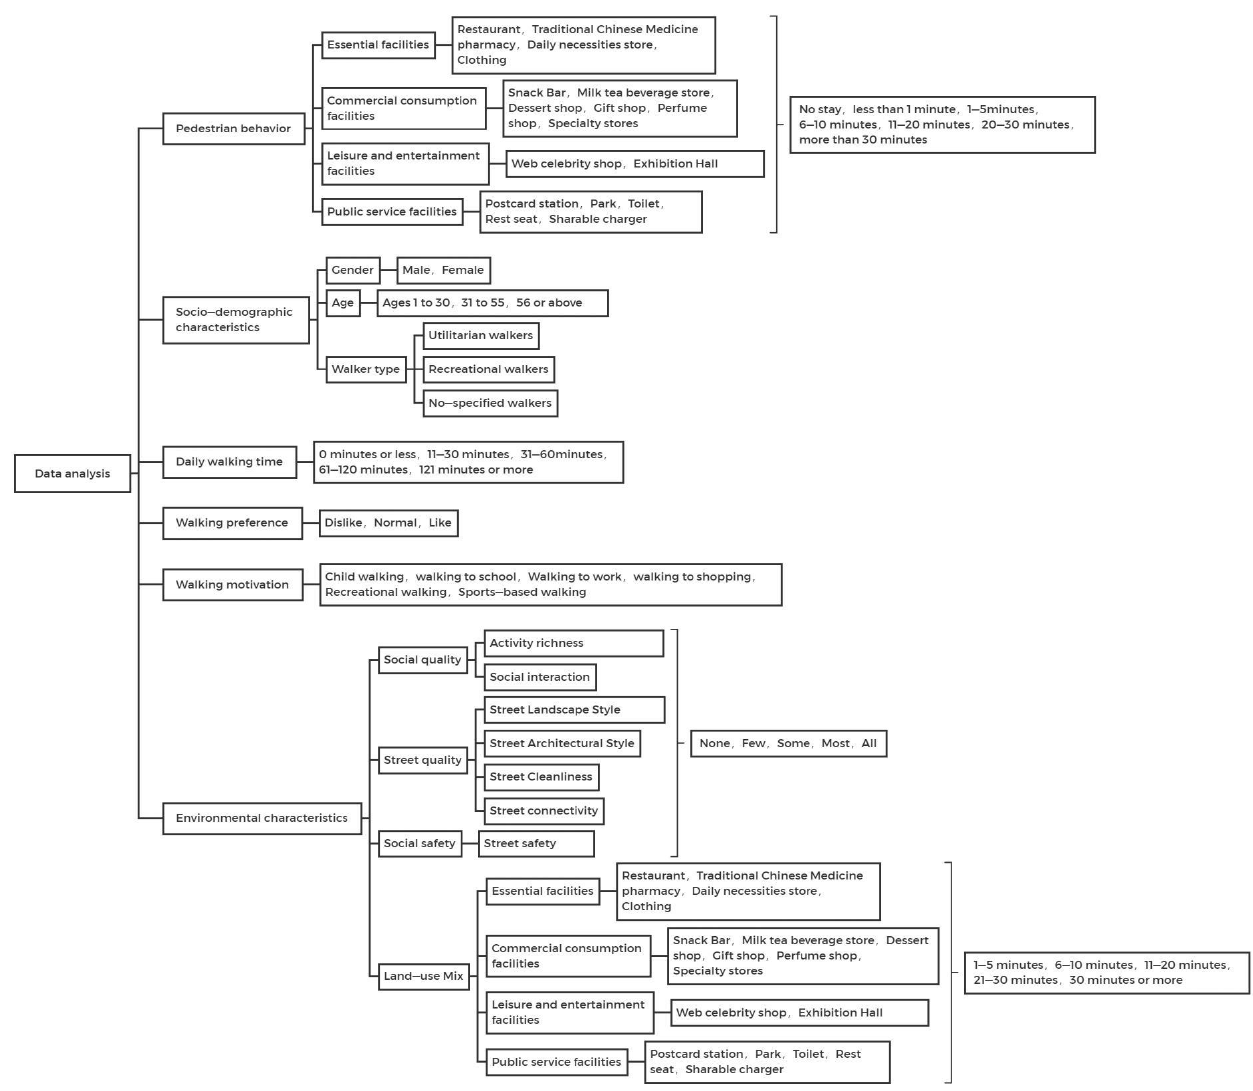
Figure 1. Data analysis framework.